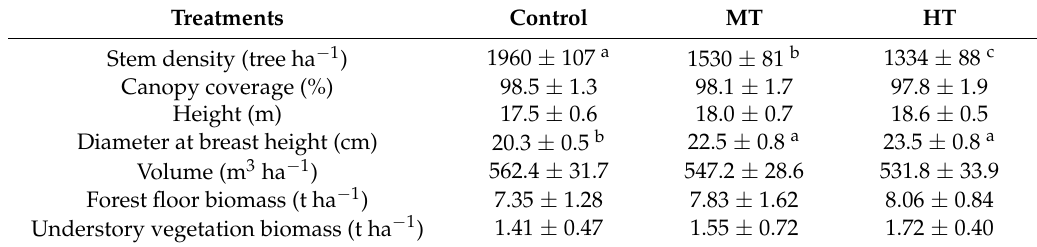
Table 1. Stand characteristics of the three thinning treatments; Control: conventional management model, MT = moderate thinning, HT = heavy thinning, TOC = total organic carbon, SOC = soil organic carbon, TN = total nitrogen; n = 3, data are shown as mean ± standard deviation (SD). Different lowercase letters indicate significant differences among the three treatments ( p <